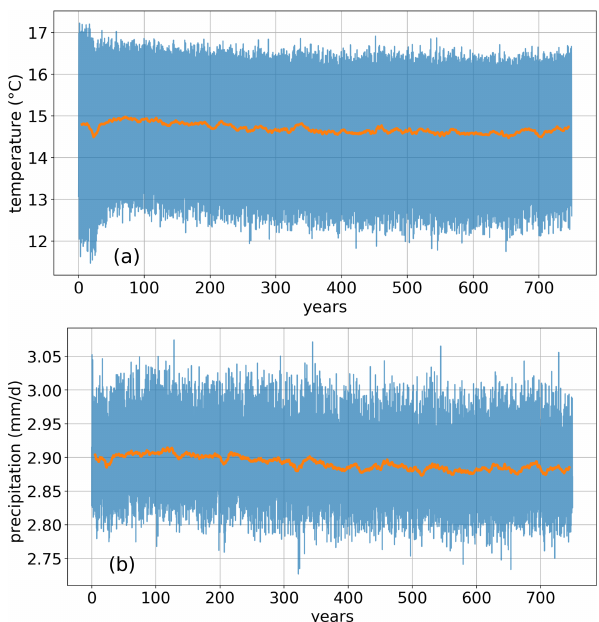
Figure 4. Time series of monthly mean global (a) temperature and (b) precipitation (blue lines), and the corresponding 10-year run- ning means (orange lines) in the pi-Control